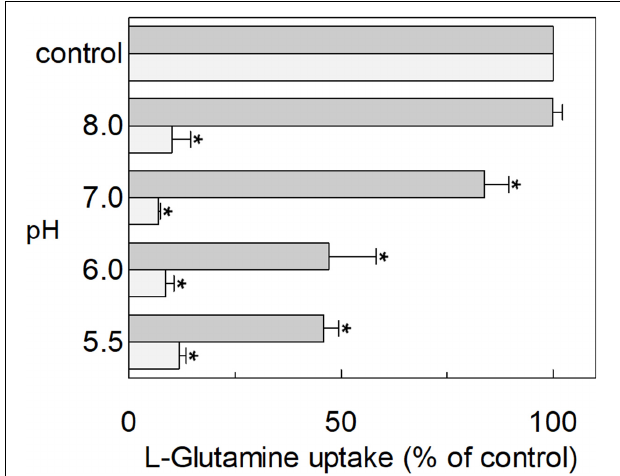
FIGURE 1 | Effect of glutamate and alanine on the glutamine transport by hASCT2 reconstituted in proteoliposomes. Purified hASCT2 was reconstituted in proteoliposomes prepared at the indicated pH and containing 10 mM glutamine, as described in materials and methods. The transport assay was started by adding 50 µ M [ 3 H]glutamine, buffered at the indicated pH, in the presence of 50 mM Na-gluconate and 1 mM glutamate (gray bar) or 1 mM alanine (light gray bar). The transport was measured in 15 min according to the stop inhibitor method. The transport was indicated as % [ 3 H]glutamine uptake with respect to the condition with no addition (control). Results are means ± S.D. from three independent experiments. *Significantly different from the control as estimated by Student’s t -test ( P <